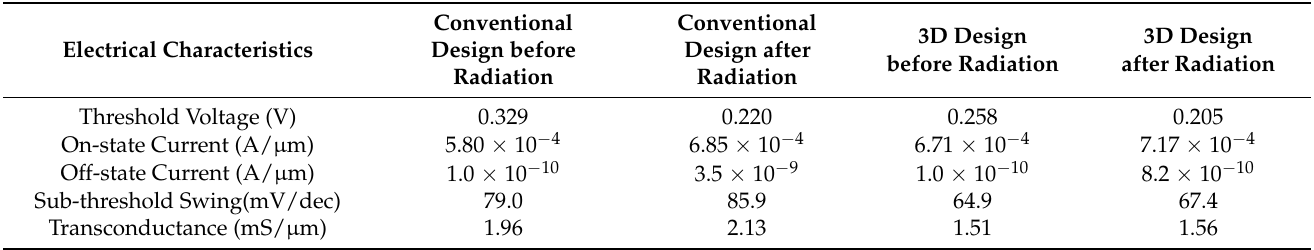
Electrical Characteristics